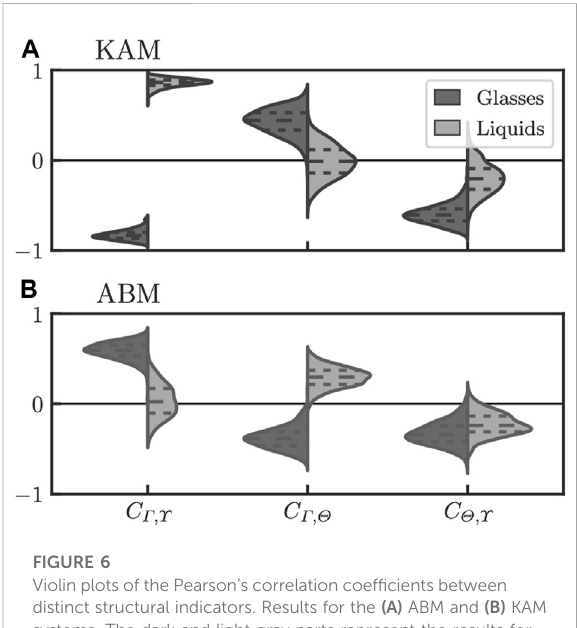
FIGURE 6 Violin plots of the Pearson ’ s correlation coef fi cients between distinct structural indicators. Results for the (A) ABM and (B) KAM systems. The dark and light gray parts represent the results for glasses liquids, respectively, as shown in the legend. The dashed lines indicate the